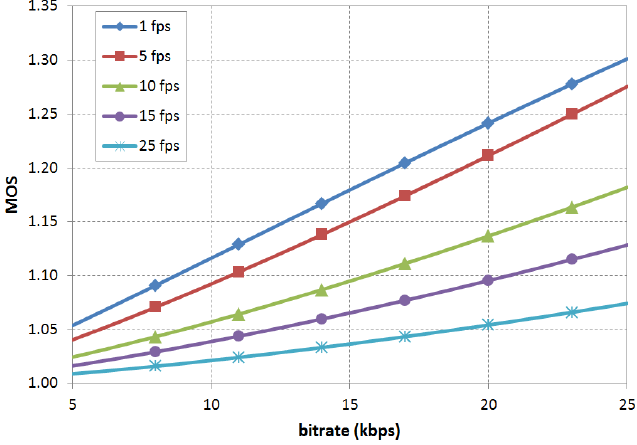
Figure 1. MOS values predicted by G.1070 for MPEG4, QVGA and 4.2’’ videos.